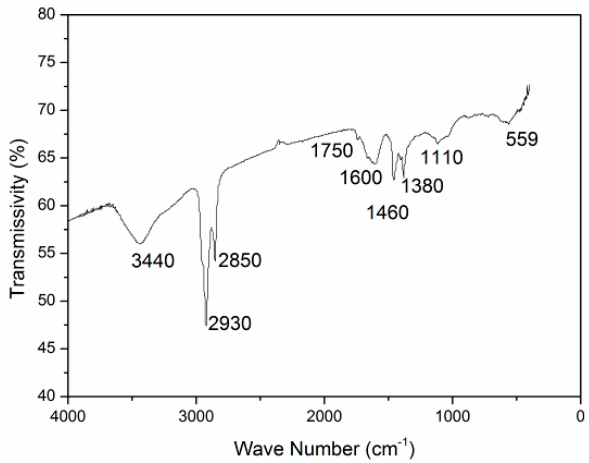
Figure 3. Fourier-transform infrared (FTIR) spectrum of neat asphalt binder.